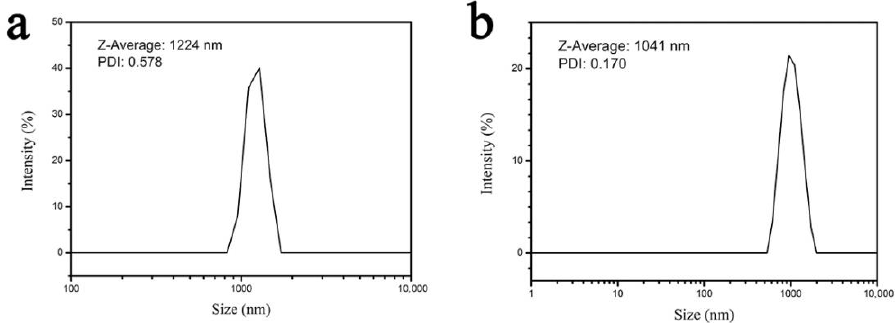
Figure 3. Comparison diragram of particle size ( a ) before and ( b ) after ball milling process.